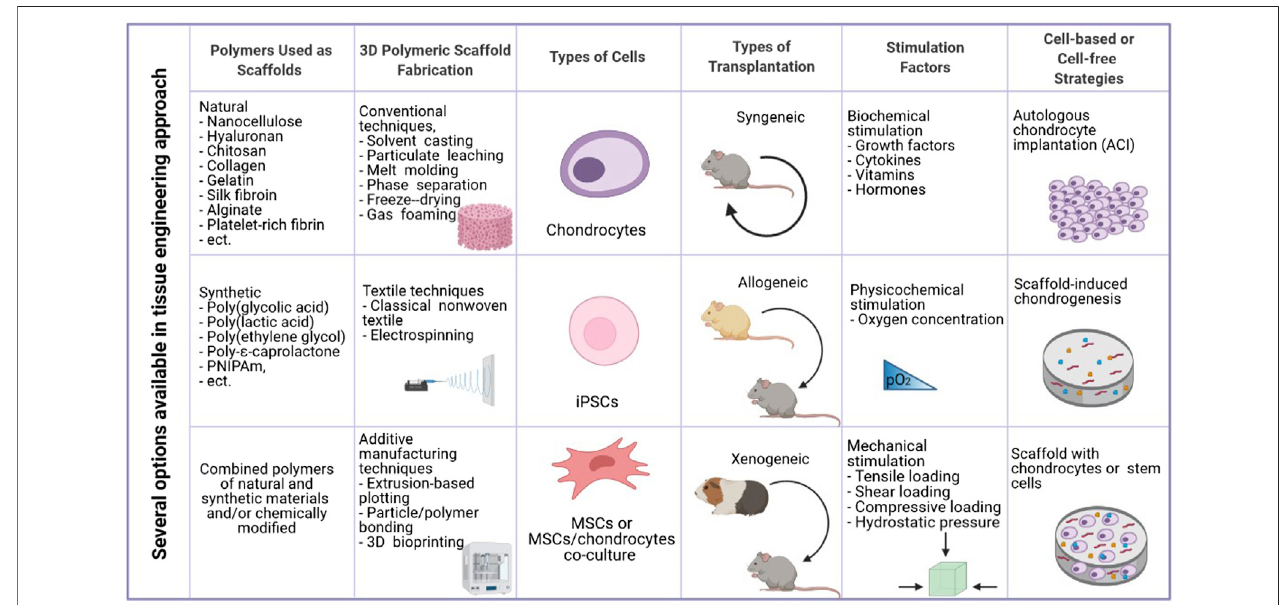
FIGURE 1 | Essential elements in cartilage tissue engineering (created in